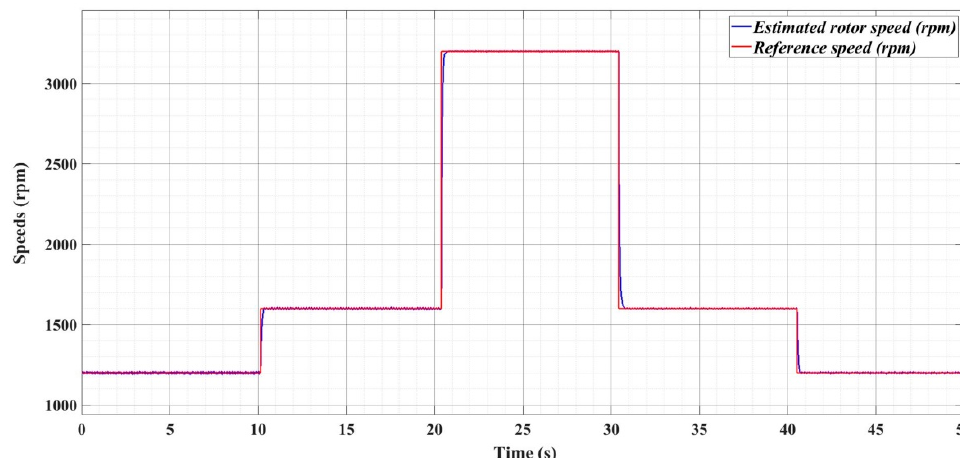
Figure 36. Real-time evolution for the estimated PMSM rotor speed—HIL stage; T L = 1 Nm.